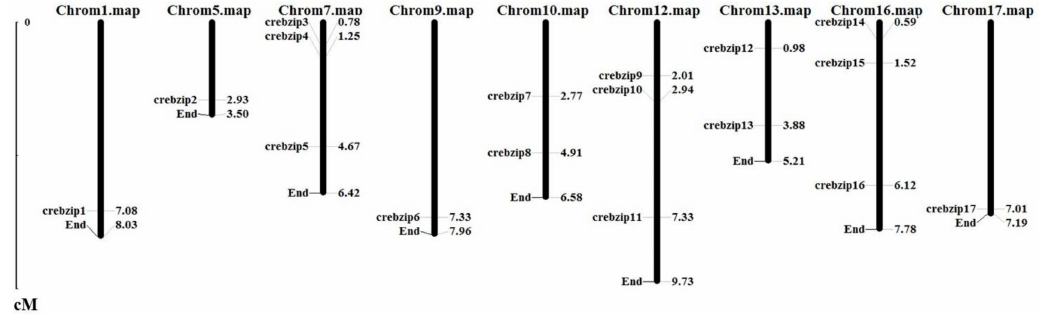
Figure 4. Distribution of CrebZIP gene family members on the C. reinhardtii chromosomes. The chromosome number is indicated at the top of each chromosome. Values next to the bZIP genes indicate the location on the